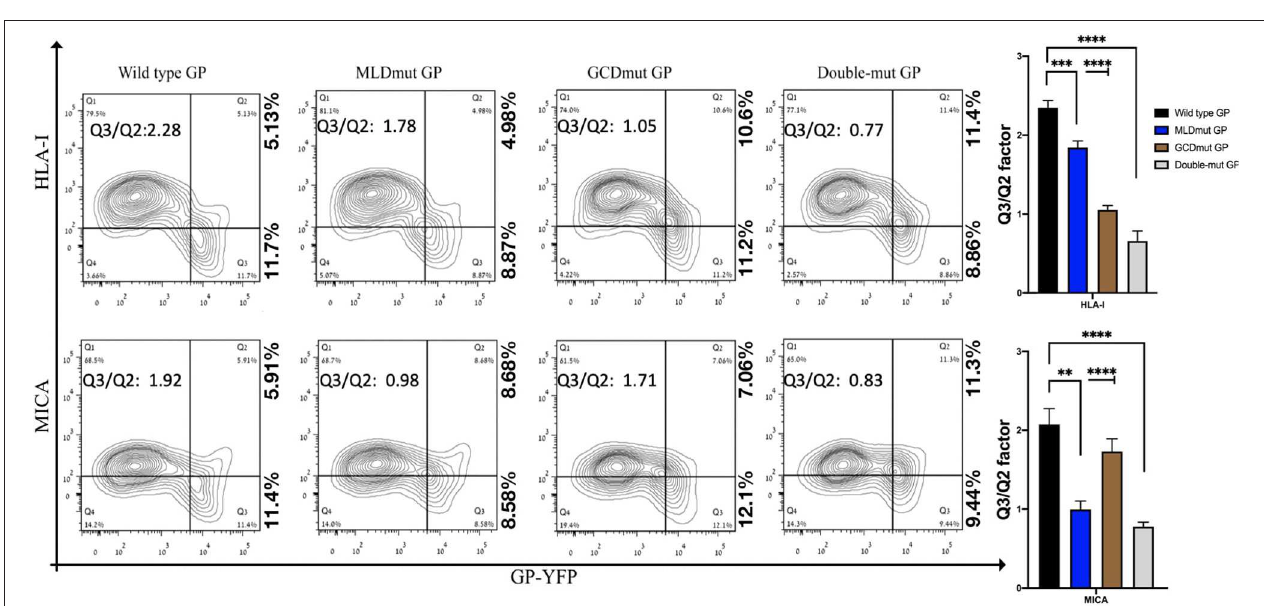
FIGURE 2 | Site-specific mutations, disrupting the N-linked glycosylations in GP1, result in the loss of steric shielding by the EBOV-GP. Flow cytometry analysis shows steric shielding effect over HLA-I (upper panels) and MICA (lower panels) ligands by wild-type and mutated YFP-fused GPs. HEK293T cells were transfected with wild-type GP or with site-specific mutants of GPs with altered N-glycosylation sites (MLD, GCD, or both domains) fused to YFP. Thirty hours post transfection, cells (without fixation or permeabilization) were co-stained with mAbs specific for HLA-I or MICA. Live cells (7AAD negative) are shown in the contour plots. Q3/Q2 values in the panels are used for evaluating the shielding of MHC-I or MICA by the EBOV GP. End right panels show summary of Q3/Q2 values depicted in the bar chart. Results shown are from one representative analysis of three independent flow cytometry analyses. Graphs representing mean ± SEM. Two-way ANOVA Sidak’s multiple comparisons (*** P < 0.005, *** P < 0.0005, **** P < 0.0001).